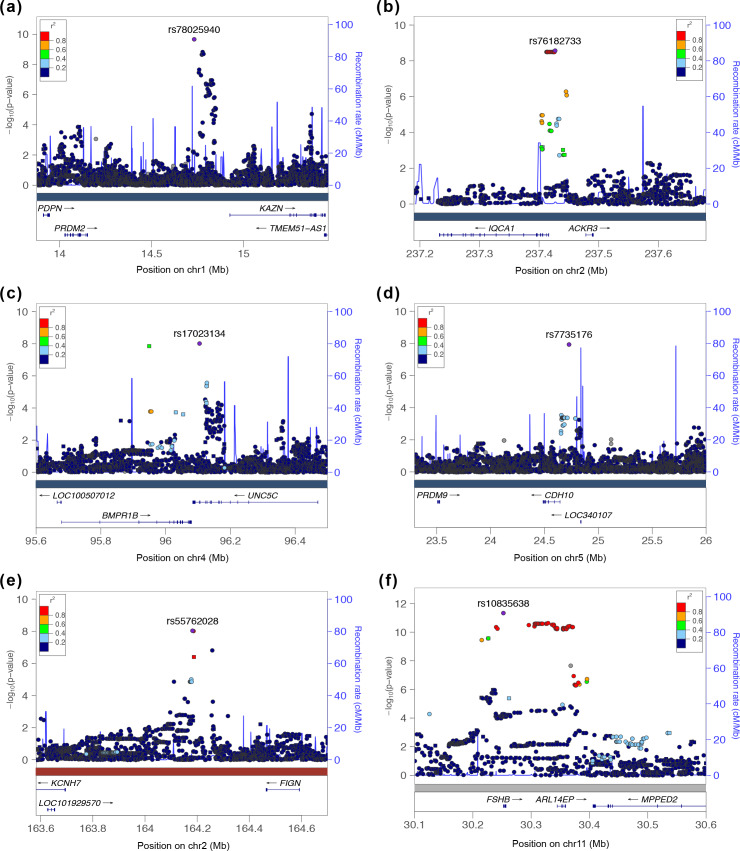
Regional association plots of genome-wide significant loci.Regional plots of association (left y-axis) and recombination rates (right y-axis) for the chromosomes (a) 1p36.21, (b) 2q37.3, (c) 4q22.3, (d) 5p14.2–p14.1, (e) 2p24.2–q24.3, and (f) 1p14.1 loci after imputation. The lead SNP in each locus is labeled and marked in purple. All other SNPs are color coded according to the strength of LD with the top SNP (as measured by r2 in the European 1000 Genomes data). Imputed SNPs are plotted as circles and genotyped SNPs as squares. LD, linkage disequilibrium; SNP, single nucleotide polymorphism.